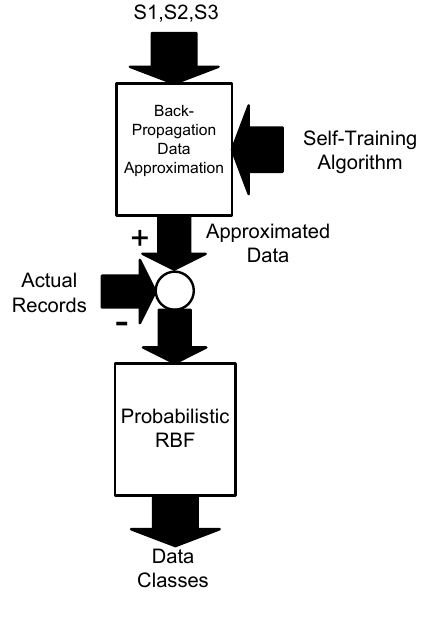
Figure 1. ANN for data approximation and classification